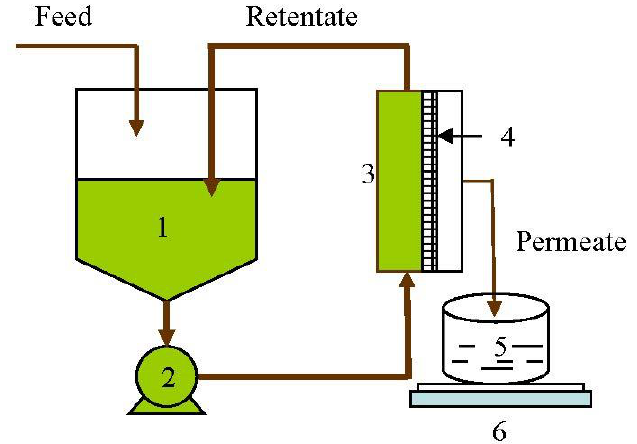
Figure 1. Schematic diagram of the lab-scale membrane separation process. 1—Feed tank; 2—Pump; 3—Flat sheet unit; 4—Membrane; 5—Permeate collection tank; 6—Weighing balance.